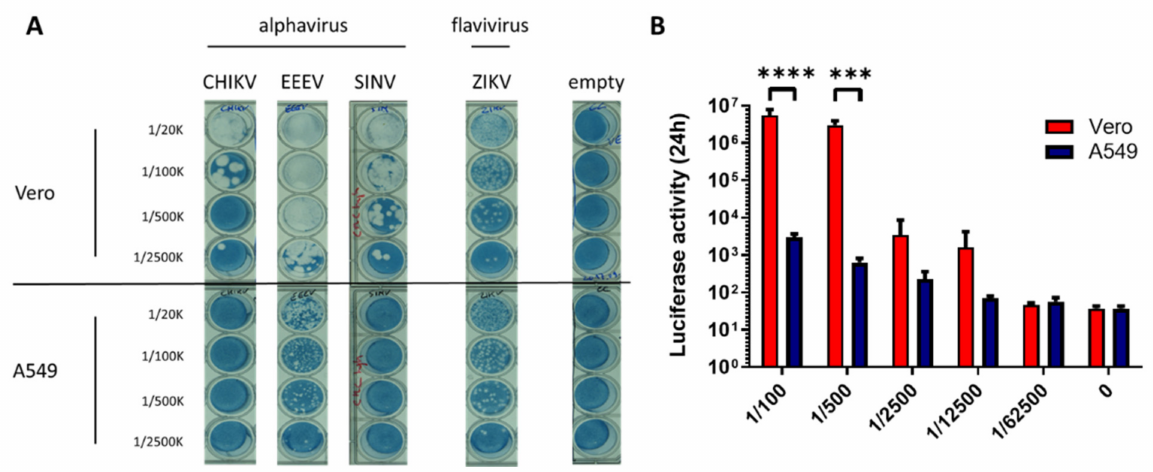
Figure 1. Infectivity of CHIKV on Vero and A549 cells. ( A ) Plaque assay of CHIKV, SINV, EEEV, and ZIKV on Vero and A549 cells. ( B ) Vero and A549 cells were infected for 24 h with a serial dilution of Nanoluc CHIKV, whereafter luciferase activity was measured. Mean ± SD is shown ( n = 3). Two-way ANOVA with Šid á k multiple comparisons was performed *** = p < 0.001 and **** = p <